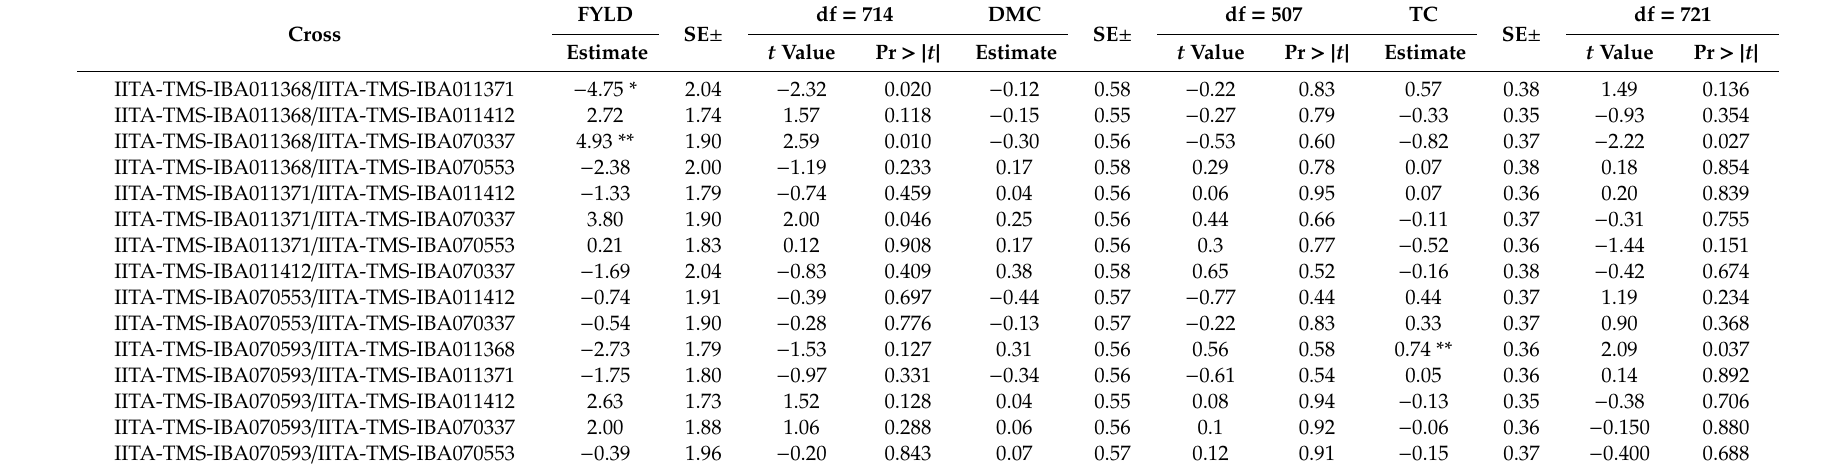
Table 6. Estimates of specific combining ability e ff ects for fresh yield, dry matter content, and total